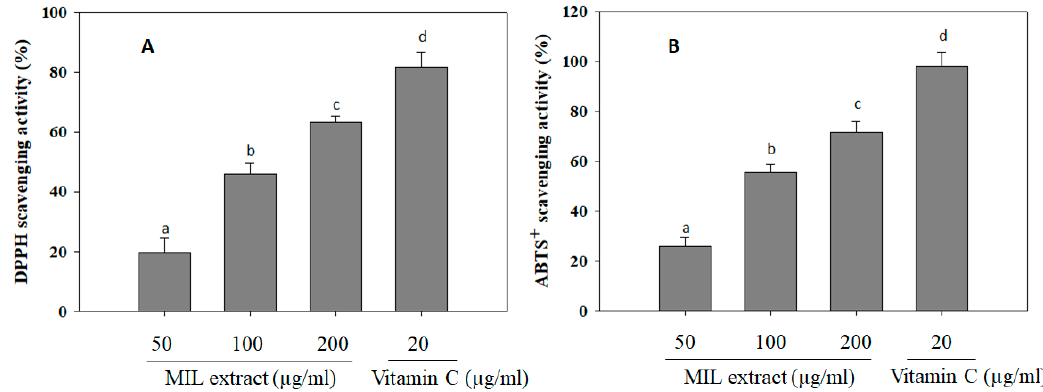
Figure 4. DPPH and ABTS + scavenging activities of M. indica leaves (MIL) extract. ( A ) The extract (100 µL) was mixed with 100 µL DPPH solution and subsequently incubated in the dark at room temperature for 30 min. Absorbance of the mixture was then measured at 490 nm. ( B ) The extract (100 µL) was mixed with 900 µL ABTS + solution and subsequently incubated in the dark at room temperature for 15 min. Measurement was taken at 734 nm. Vitamin C was used as a positive control. Each determination was made in three independent experiments, and the data are shown as means ± SD. Different letters a–d indicate significant difference among groups ( p < 0.05) by Duncan’s multiple-range test.